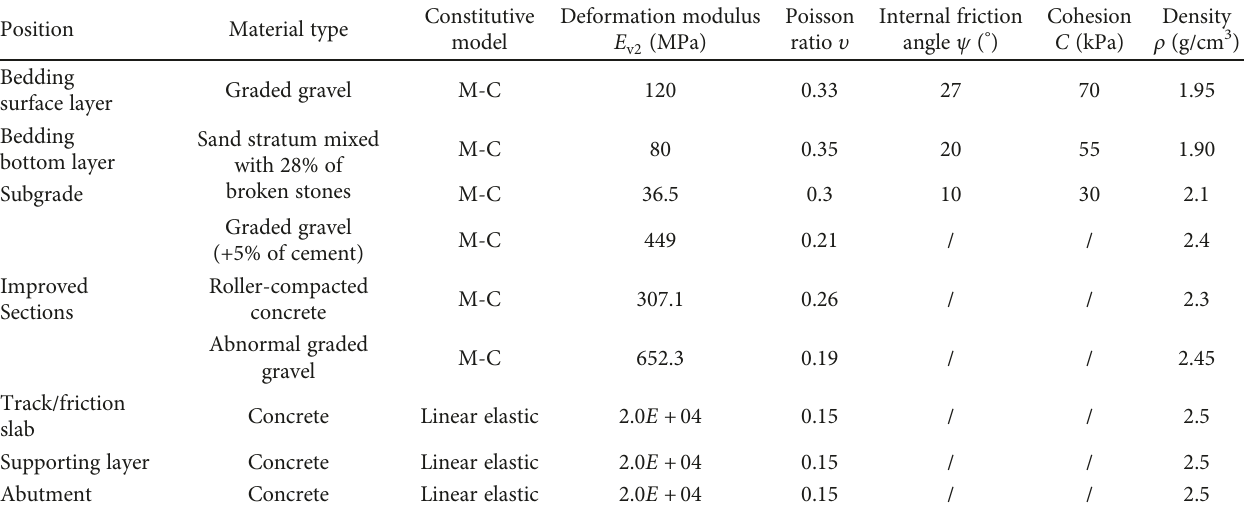
Table 2: Physical and mechanical characteristic parameters of the